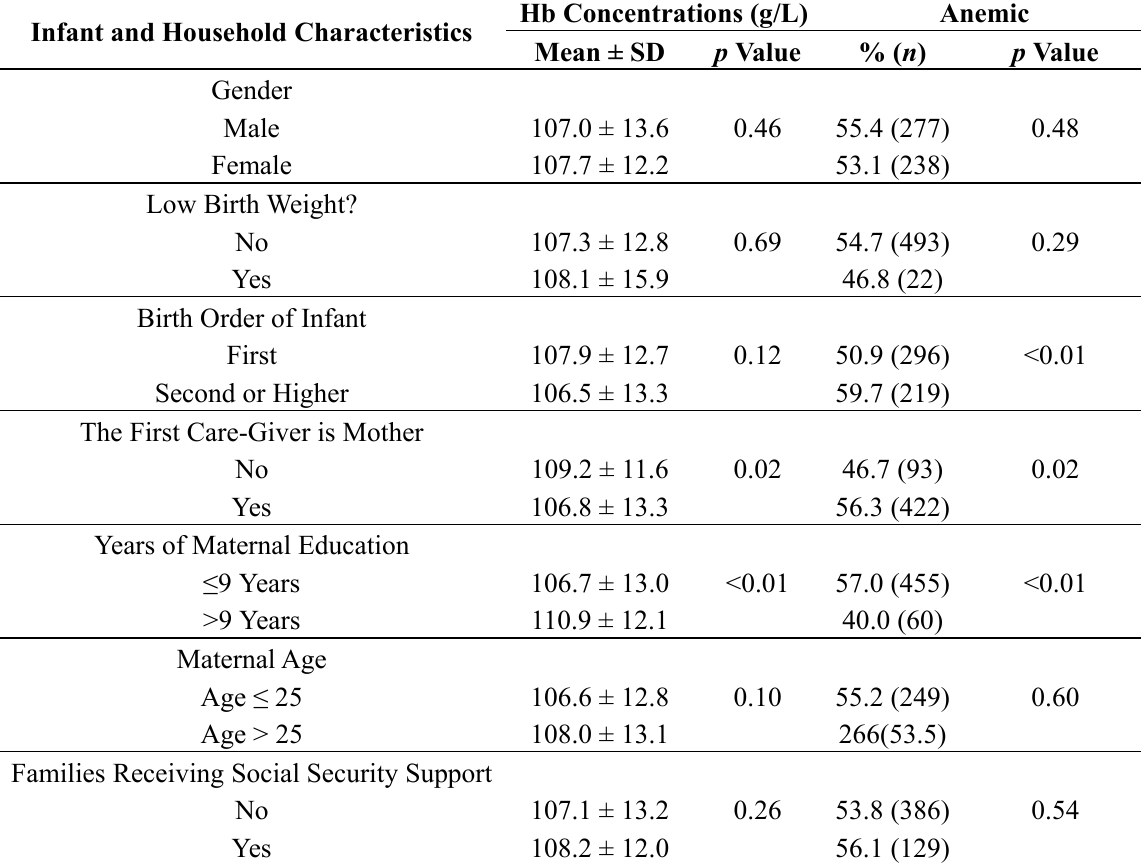
Table 3. Hemoglobin concentrations and anemia prevalence of sample infants in rural Shaanxi Province by infant